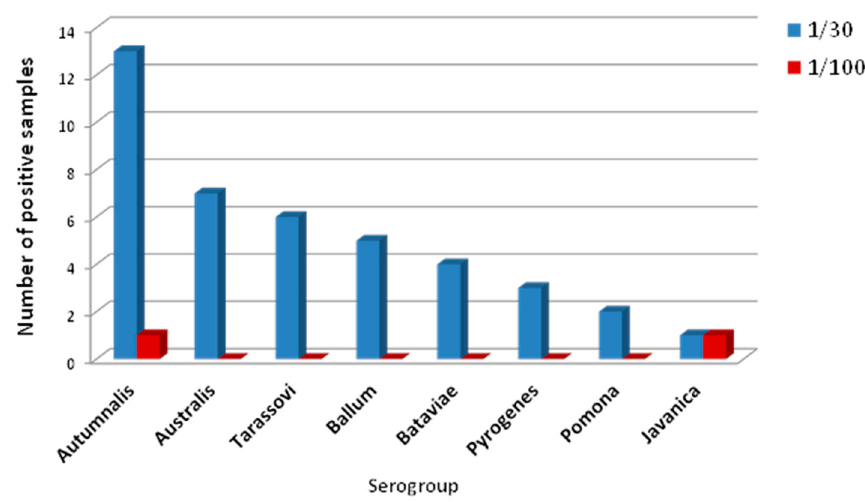
Figure 1. Distribution of Leptospira serogroups in the swine unit in 113 animals. The chart shows the results among 37 sows positive for MAT with a cut-off threshold of 1/30. The bars indicate the distribution of the Leptospira serogroups, considering the most prevalent serogroup.